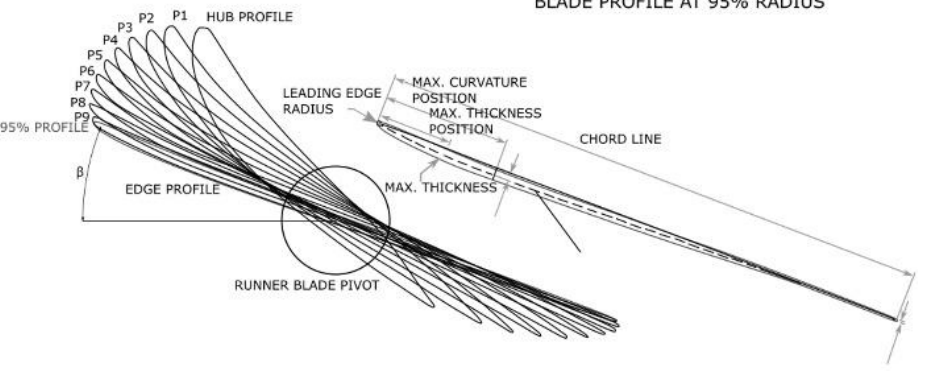
Figure 2. Selection of a 25° angle on a modified bulb turbine hydrofoil.